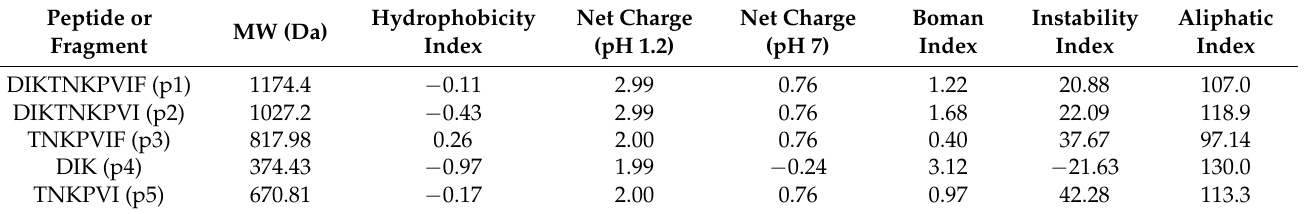
Table 1. Physicochemical properties of the patatin-derived anti-inflammatory decapeptide (p1) and its fragments (p2–p5) released after in silico gastrointestinal